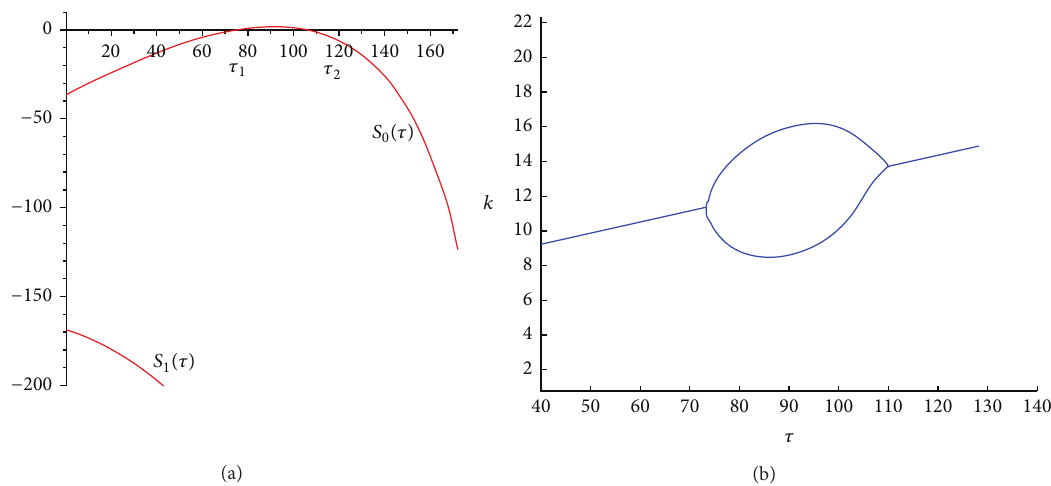
Figure 1: (a) Graph of stability switch in terms of time delay for the system (3). 𝜏 1 ≅ 74.22 , 𝜏 2 ≅ 106.43 ; (b) bifurcation diagram.